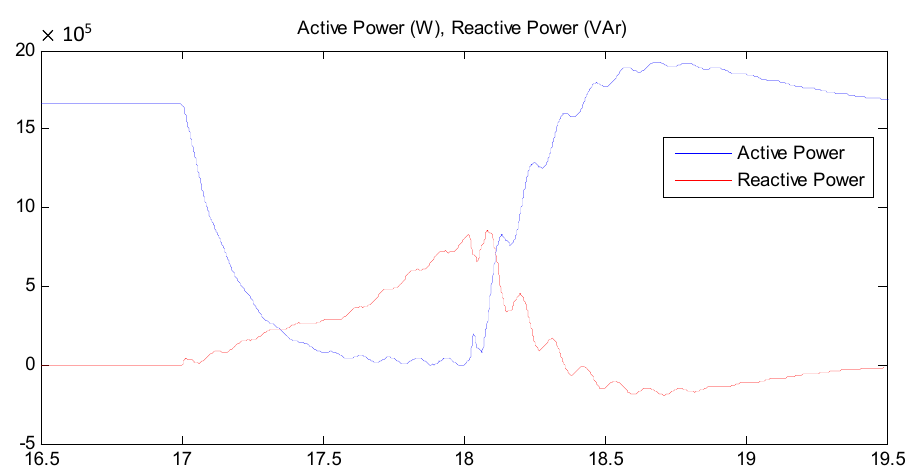
Figure 7. Electric power exchanged with the grid during voltage sag. Active power, W. Reactive power,